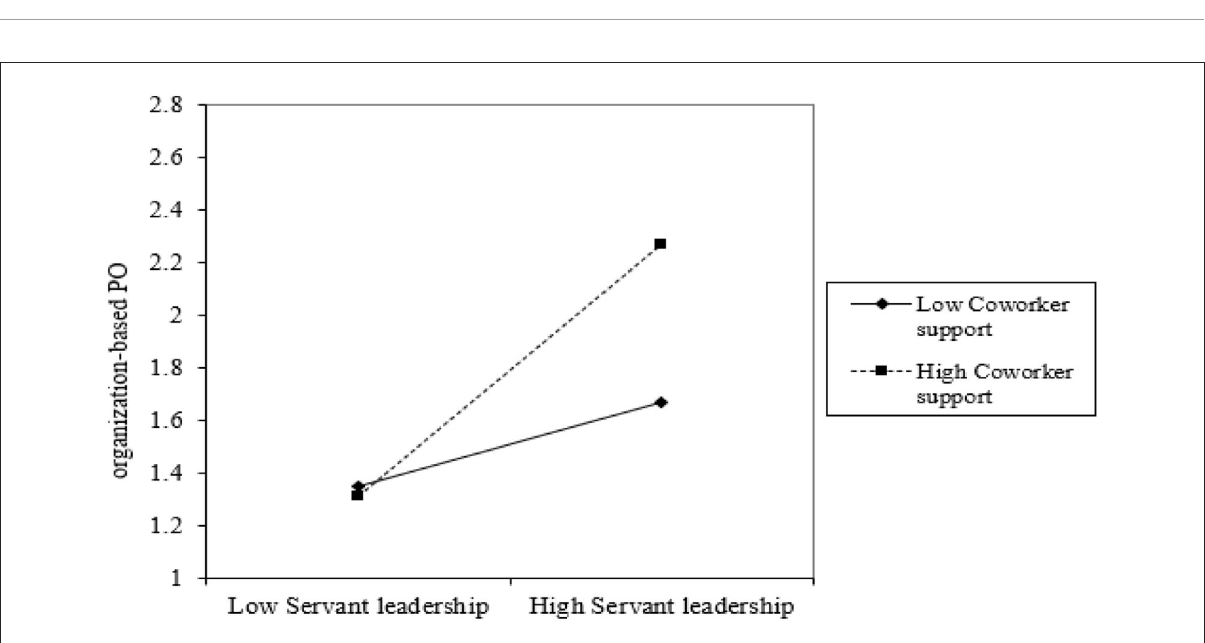
FIGURE2 Interaction of SL and coworker support on organization-based